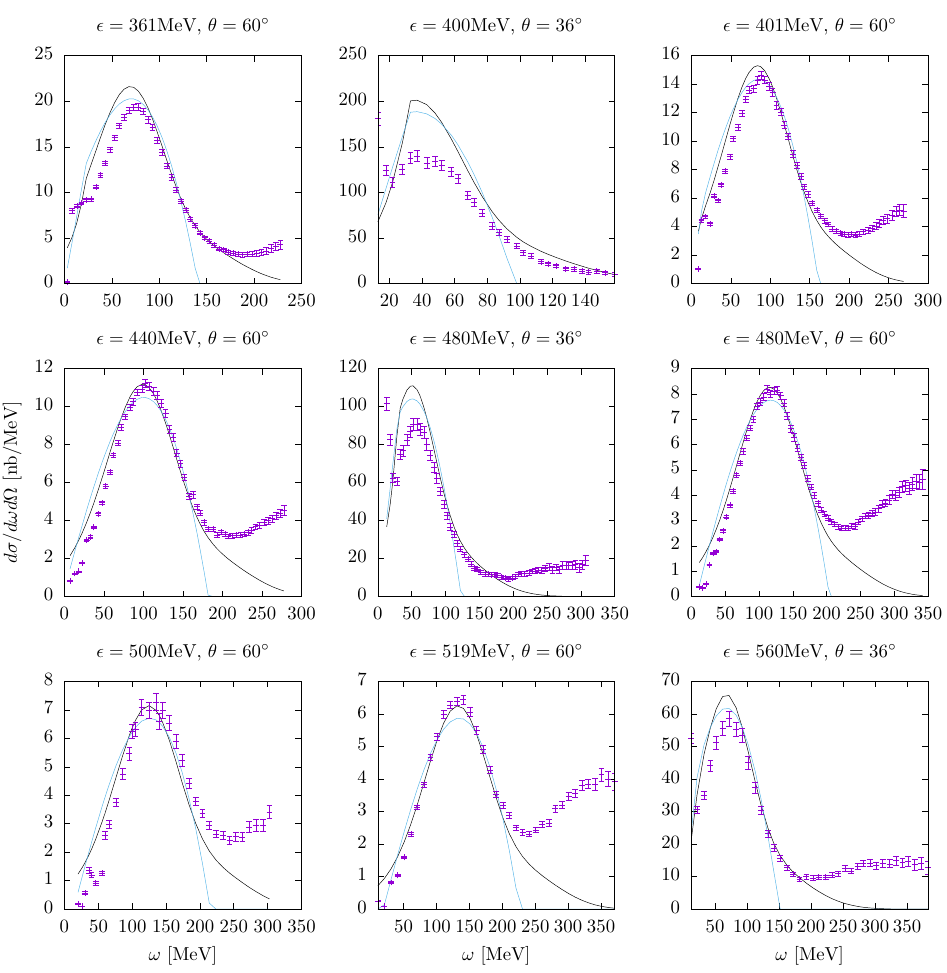
Figure 8. Quasielastic ( e , e (cid:48) ) cross section of 12 C as a function of ω for several values of the electron energy, (cid:101) , and scattering angles θ , computed with the present SuSAM* model (black lines) compared to the RFG with effective mass (blue lines). Experimental data (purple lines) are from refs.